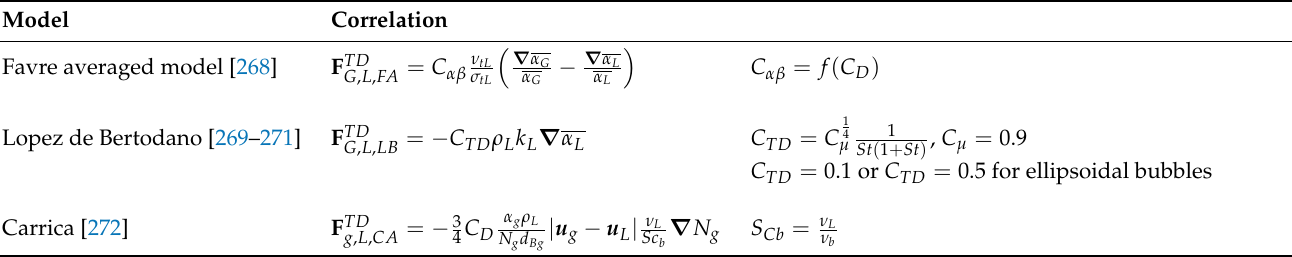
Table 10. Turbulent dispersion force